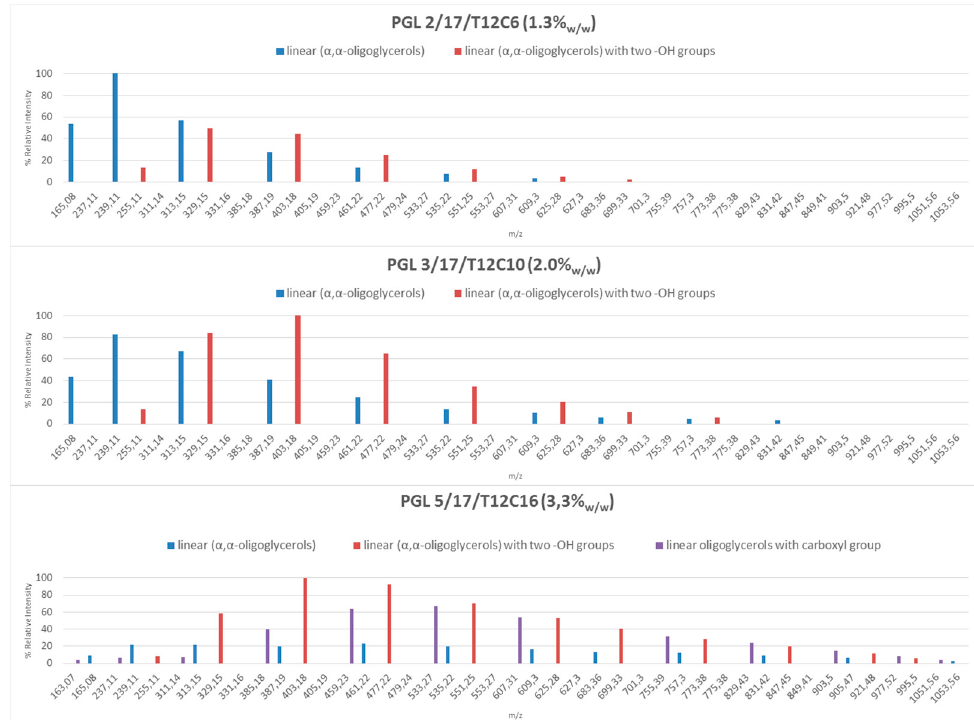
Polymers 2018 , 10 , x FOR PEER REVIEW